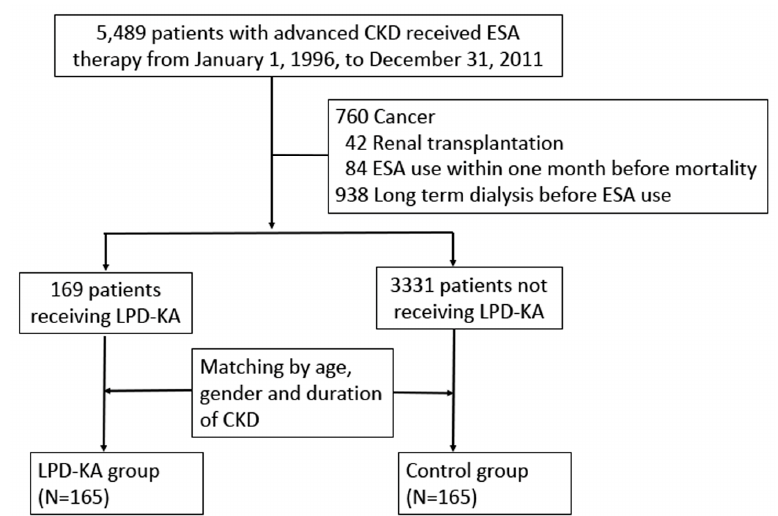
Figure 1. Patient selection flow. CKD = chronic kidney disease; DM = diabetes mellitus; ESA = erythropoiesis-stimulating agent; KA = ketoanalogues; LPD = low-protein diet.